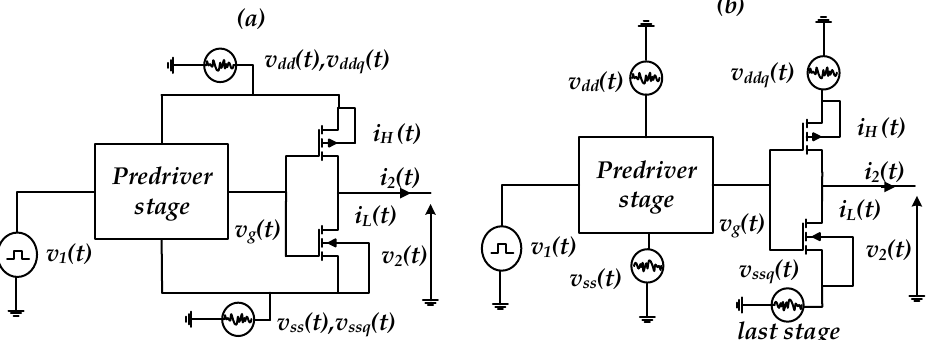
Figure 5. Simulation setups used to evaluate the p2p eye jitter. ( a ) two-tone voltage noise applied to the shared PG rails. ( b ) two-tone voltage noise applied the decoupled PG rails. Table 1. Different PVT corners used to evaluate the PGSIJ via transient simulations of IO buffer circuit (𝑡) = 𝑣 (cid:3046)(cid:3046)(cid:3044)(cid:3041)(cid:3042)(cid:3036)(cid:3046)(cid:3032) (𝑡) . In the shared case, P/G terminals of the pre-driver and 𝑣 (cid:3031)(cid:3031)(cid:3044)(cid:3041)(cid:3042)(cid:3036)(cid:3046)(cid:3032) (𝑡) and 𝑣 (cid:3046)(cid:3046)(cid:3044) last stage are shorted and a single voltage noise is used at the P/G supplies. The